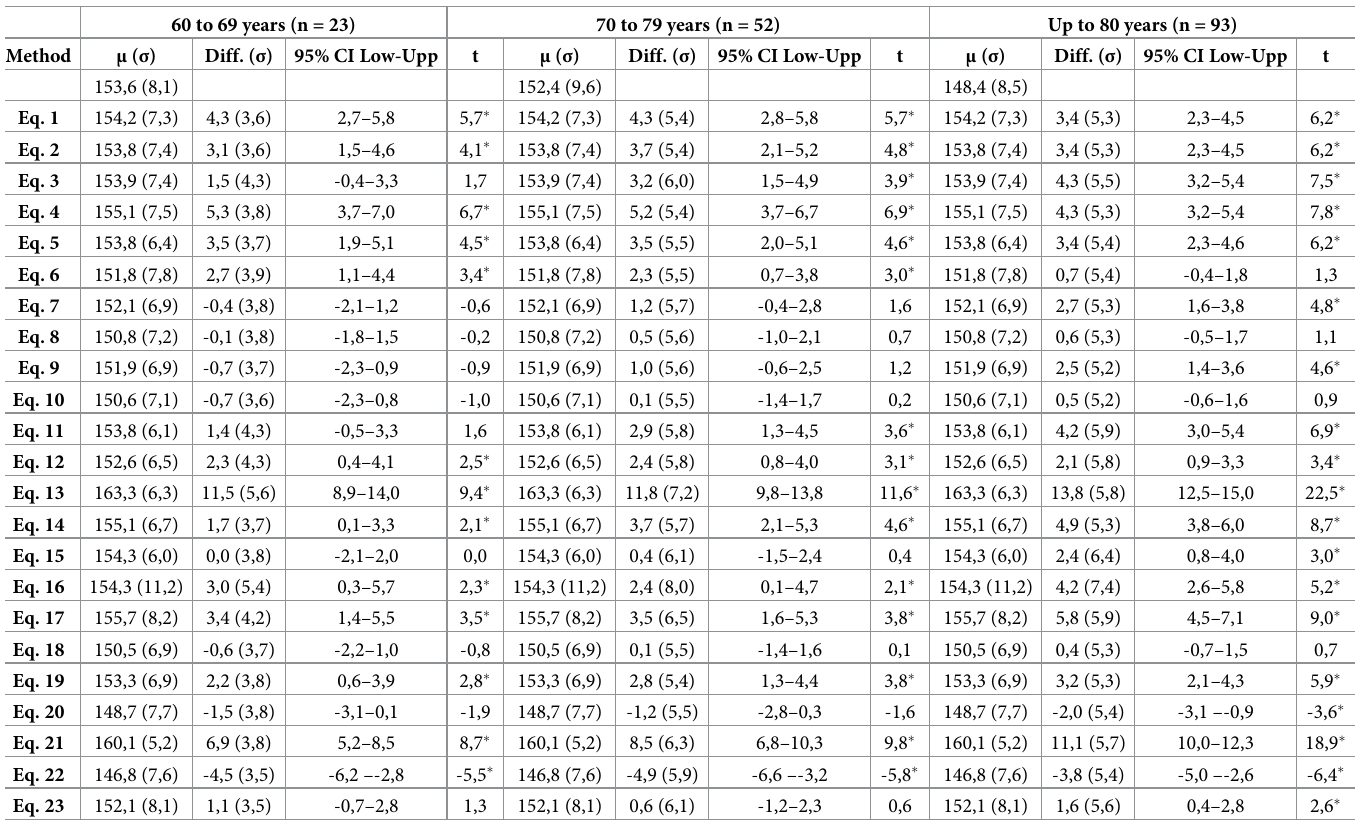
Table 3. Mean values and analysis of mean differences in stature and height estimated by predictive equations for elderly living in nursing homes stratified by age group, Brazil,